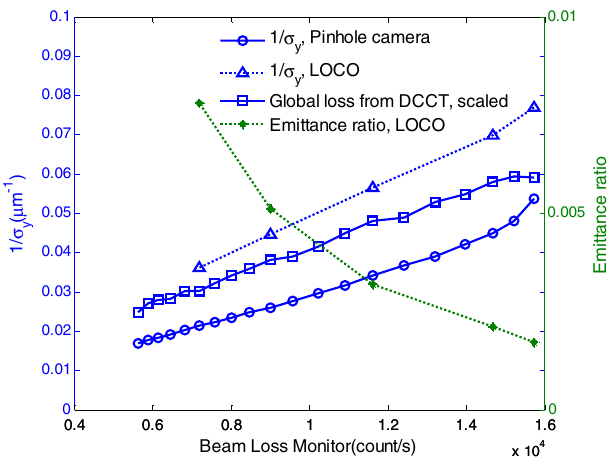
FIG. 2 (color online). Experimental results showing the mon- otonic relationship of beam loss rates vs vertical beam size, scaled global loss rate, and emittance